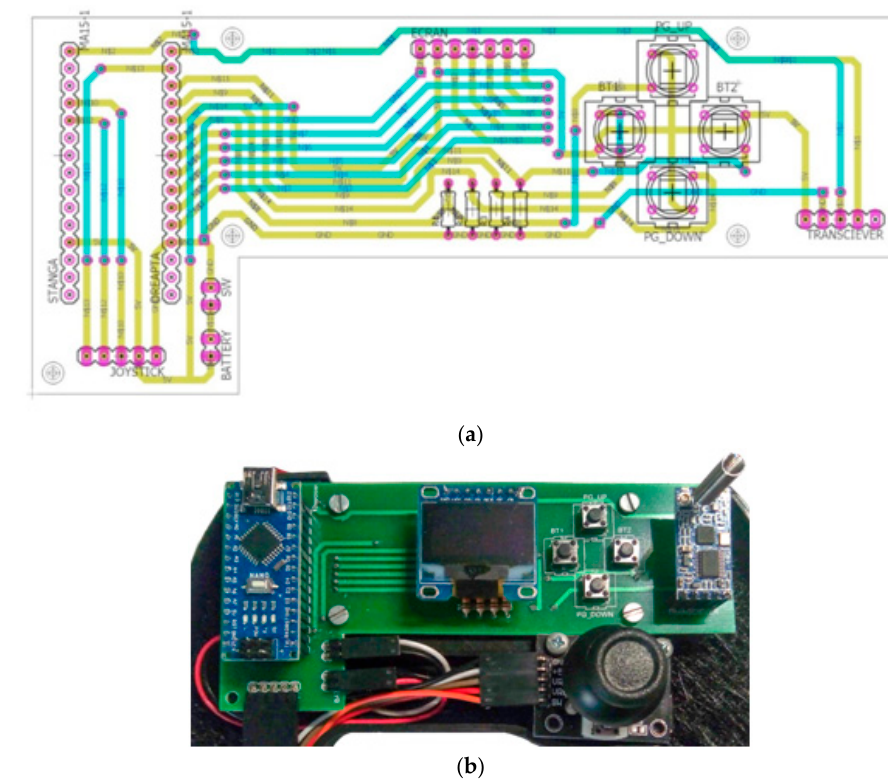
Figure 7. The designed ( a ) and implemented ( b ) electronic circuit of UAV.